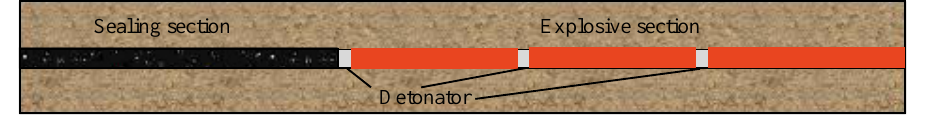
Figure 6. Charging